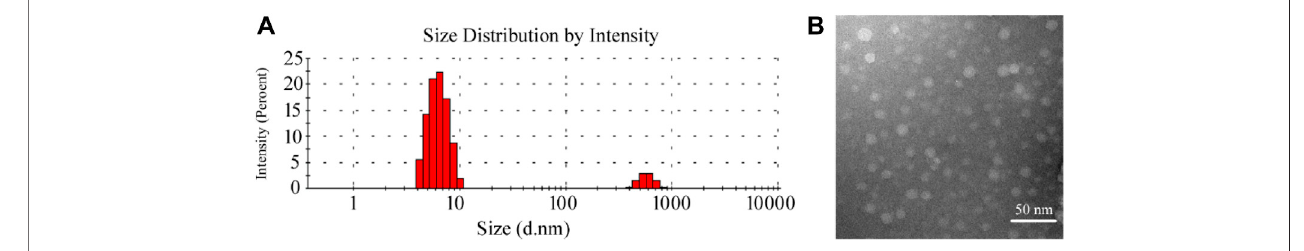
FIGURE 1 | Characterization of the HP- β -CD/MSZ inclusion complex. (A , B) are the particle size distribution and TEM diagram, respectively.